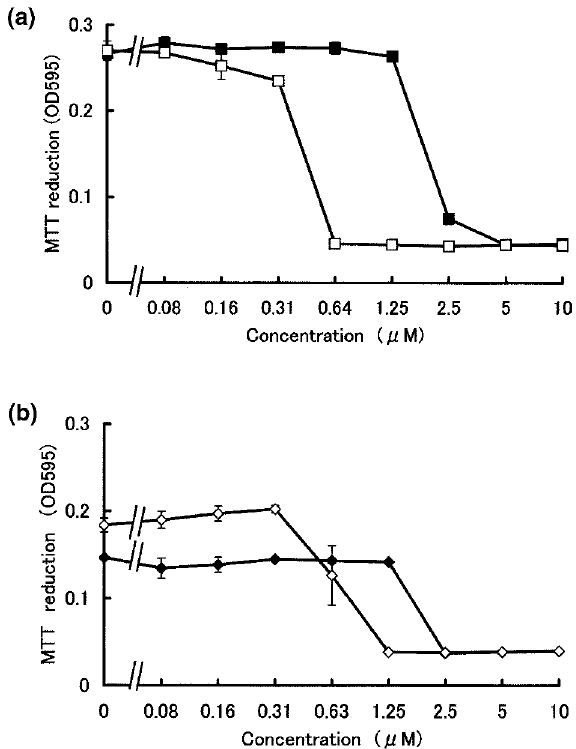
FIG. 3. EL-4 cell cytotoxicity of the cell-membrane-impermea- ble Zn-chelator DTPA or the cell-membrane-permeable Zn- chelator TPEN. The cells were cultured with (a) DTPA or (b) TPEN in standard medium (closed symbols) or in divalent- cation-depleted medium (open symbols). MTT assays were preformed after culturing for (a) 48h or (b) 24h. Bars represent standard deviations of triplicate measurements. When bars are not shown, they are smaller than the size of the